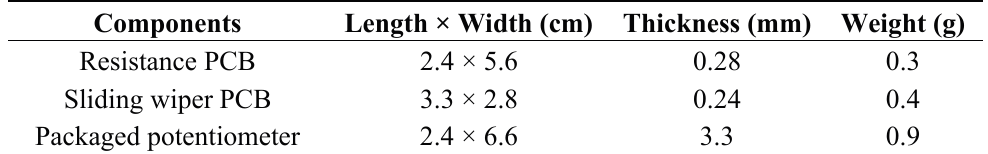
Table 1. Specifications for components of the potentiometric